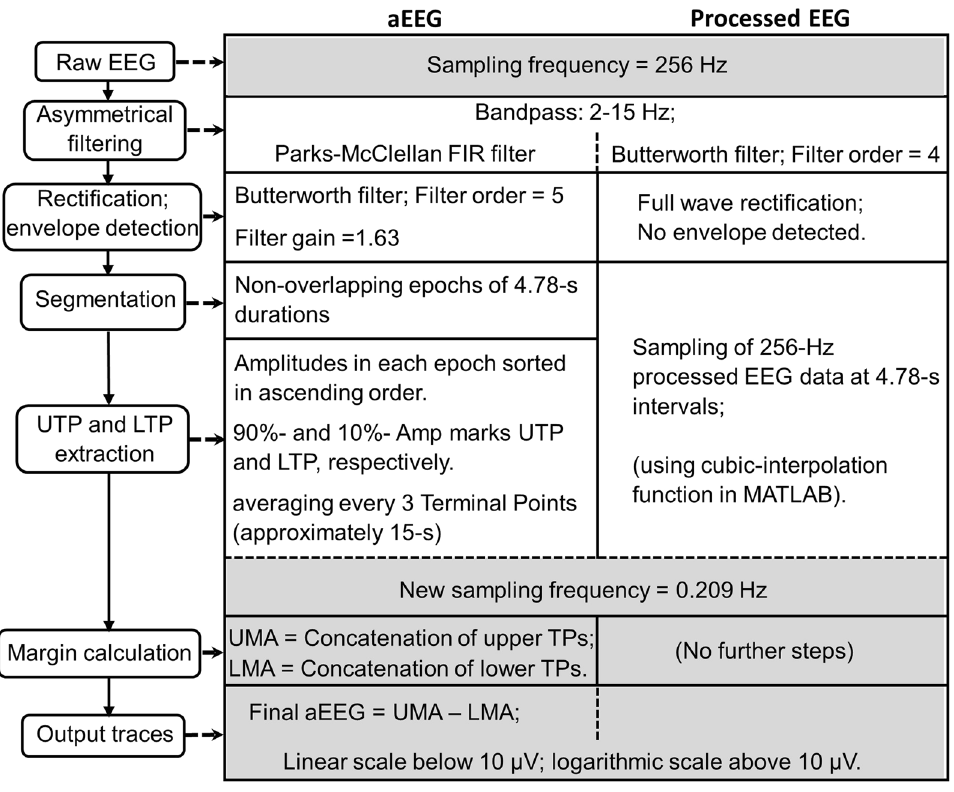
Figure 4. Methodological overview of different steps among two data processing algorithms, enroute to obtaining the common sampling rate for aEEG/processed EEG and NIRS, [Adapted from 6 ]; TPs terminal positions; UTP upper terminal positions; LTP lower terminal positions; UMA upper margin amplitudes; LMA lower margin